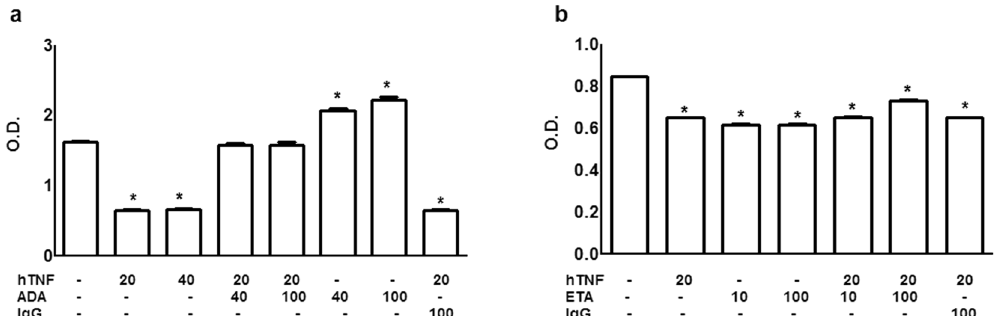
Figure 4. Anti-TNF compounds effect on C. albicans biofilm. Human TNF (hTNF ng/mL), the anti-TNF monoclonal antibody Adalimumab (ADA ng/mL), the IgG coupled soluble TNF-receptor Etanercept (ETA ng/ mL), human immunoglobulin G (IgG) or ( − ) Medium were added isolated or combined to C. albicans